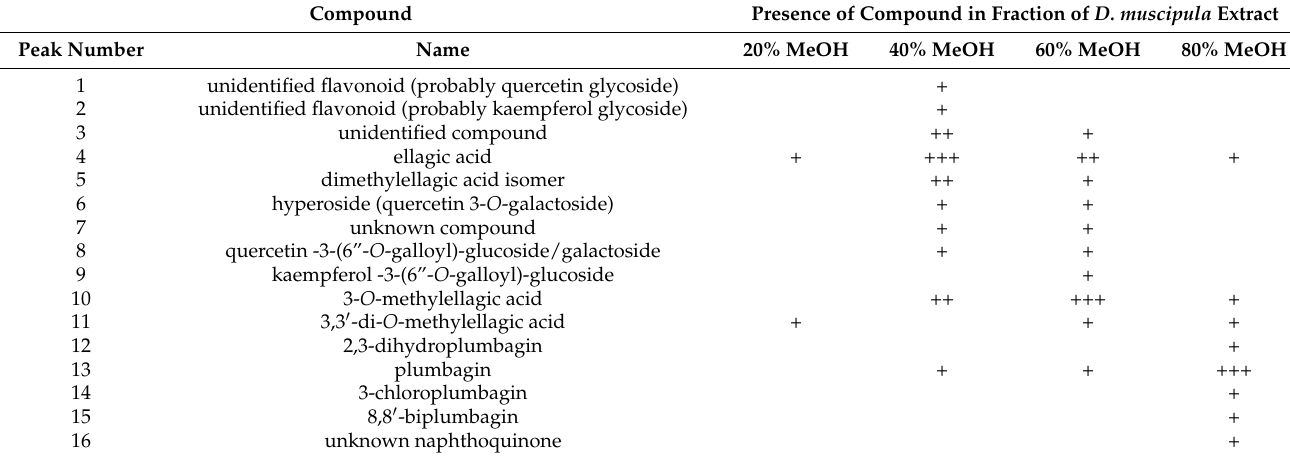
Table 4. Summary of HPLC-DAD-ESI/MS analysis on the presence of compounds in fractionated tetrahydrofuran extract obtained from D. muscipula tissues in Soxhlet extractor. Compound Presence of Compound in Fraction of D. muscipula Extract Peak